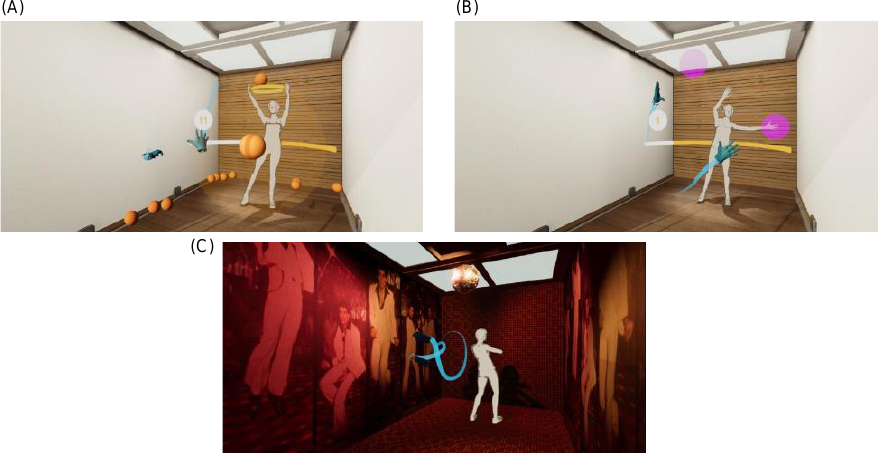
Figure 4. Three exercises of the ET exergame: ( A ) ball game; ( B ) high five; ( C ) hustle